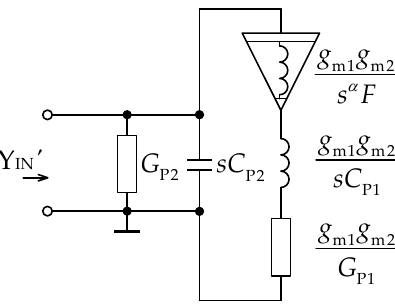
Figure 4. Substitute circuit providing the input admittance (7); the relations in the schematic express admittances of the particular elements.